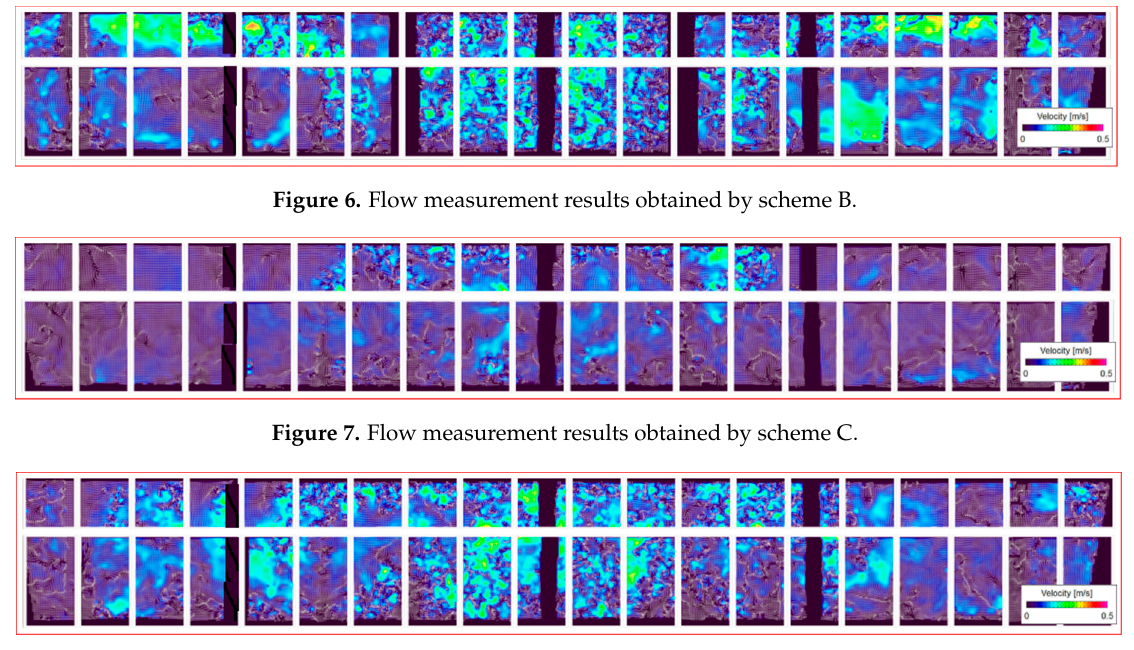
Figure 8. Flow measurement results obtained by scheme D.